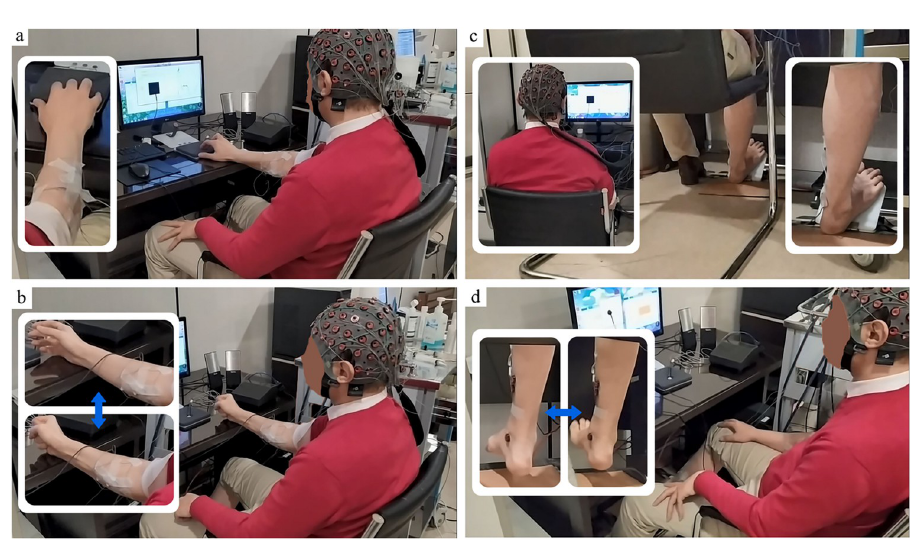
Fig 2. The experimental setup of the study. Four completed tasks, subjects, channels, and setup are presented in the picture. A) In task 1 as a static task; subjects did the task with the middle figure and held the output force in a specific range. B) In task 2 as a dynamic task; subjects opened and closed their hand with normal voluntary speed. C) Task 3 is static; the subjects held the pedal to generate the output force in the considered range. D) Task 4 as a dynamic task, subjects did the dorsiflexion and plantar flexion with normal voluntary speed. For all the tasks, subjects saw the monitor to do the task based on the timeline shown on screen.